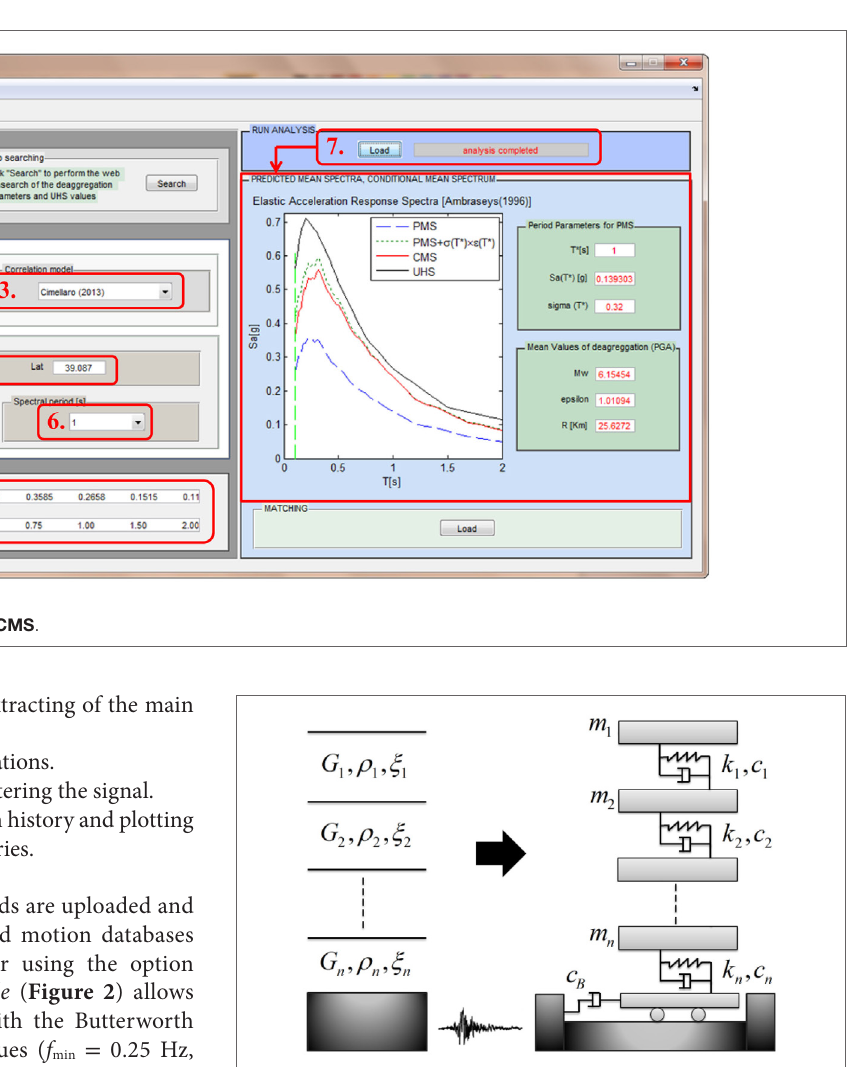
FigUre 4 | Multi-degree of freedom system with base excitation